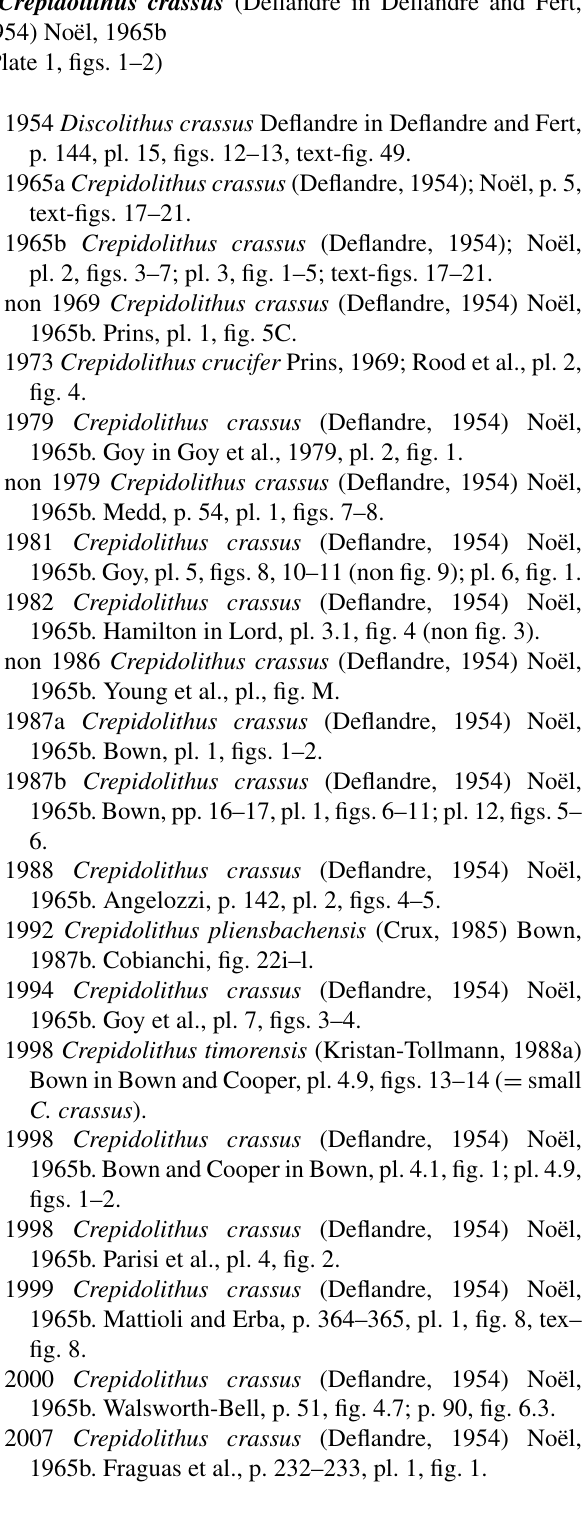
2019 Crepidolithus crassus (Deflandre in Deflandre and